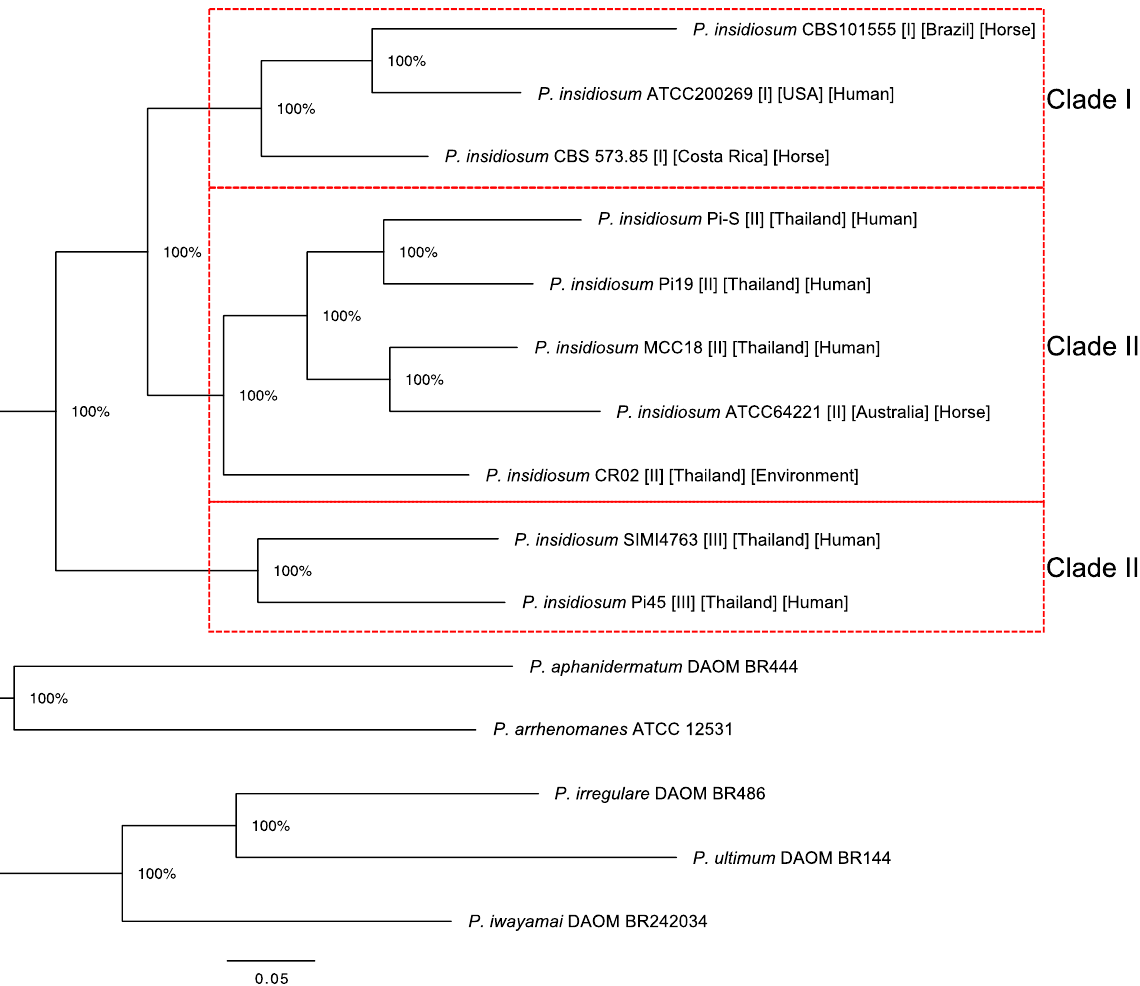
Figure 1. A phylogenetic tree based on 166 single-copy core genes in the genomes of 10 P. insidiosum strains and 5 other Pythium species. The bootstrap values, used to indicate the reliability of the result, are shown on each branching node. Red boxes depict groups of the P. insidiosum strains assigned to rDNA-based genotype clades I, II, and III.